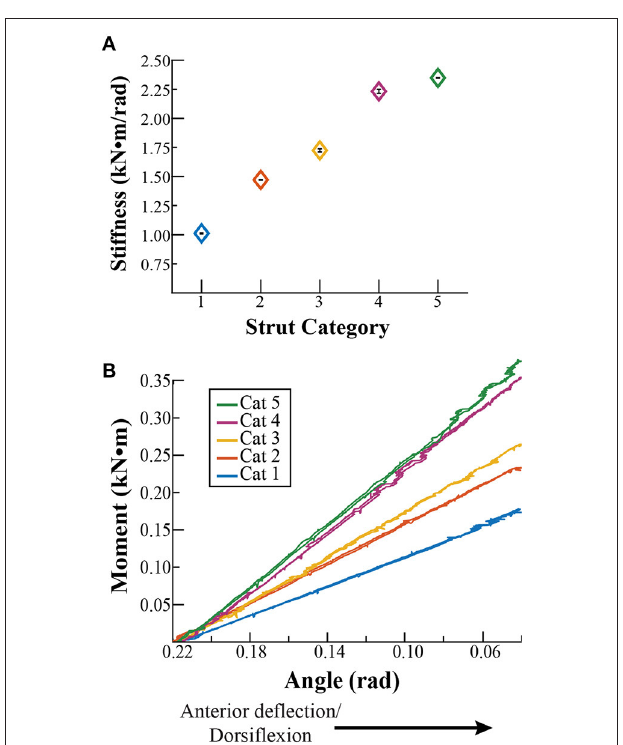
FIGURE 2 | (A) Stiffness values ( ± SD) for each strut stiffness category (Cat) with anterior deflection, calculated as the quotient of the moment at an angle of 0.18rad (10 ◦ ) for Cat 1–5. (B) Representative moment versus angle relationships for each Cat during anterior deflection from an angle of 0.22rad (13 ◦ ) relative to horizontal at the beginning of the test, to 0.04 (2.3 ◦ ) rad at the finishing point of the test, for 0.18rad (10 ◦ )of